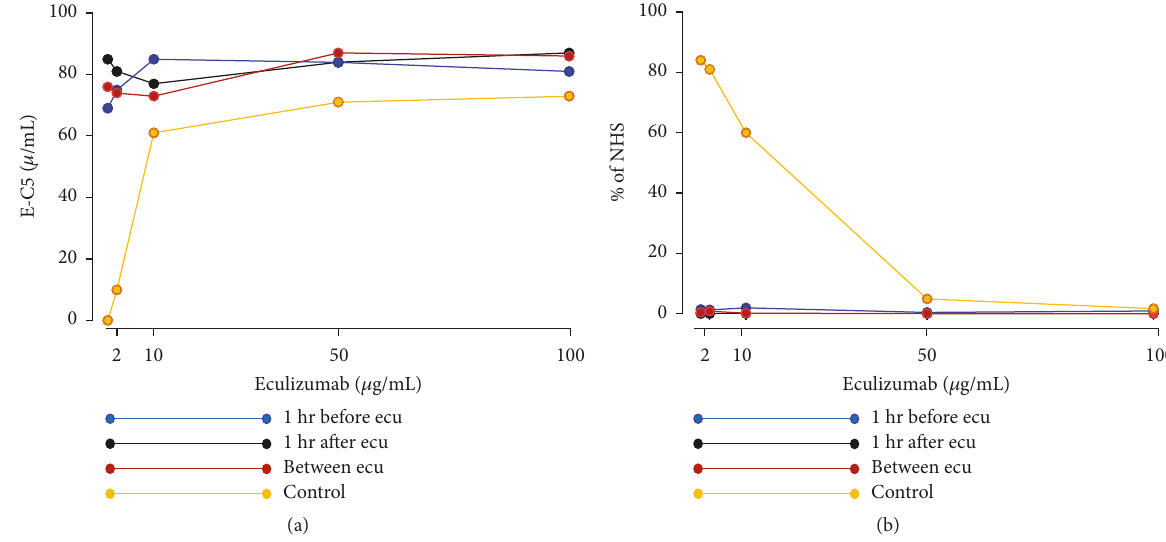
Figure 1: Patient samples and control sera assayed for eculizumab-C5 (E-C5) complexes and total complement activity. Three samples from the aHUS patient were examined: (1) sample obtained 1 hr before eculizumab infusion (“1 hr before ecu”), (2) sample obtained 1 hr after eculizumab infusion (“1 hr after ecu”), and (3) sample obtained 1 week after and 2 weeks before eculizumab infusion (“between ecu”). Control sera were obtained from 20 healthy controls. (a) Samples were incubated with increasing concentrations of eculizumab (0-100 𝜇 g/mL) and E-C5 complexes were measured (concentration is given in eculizumab-equivalent amounts). (b) Samples were incubated with increasing concentrations of eculizumab (0-100 𝜇 g/mL) and classical pathway complement activation was measured by the Wieslab (cid:2) assay, detected as % of a normal human standard sera by the kit, defined to contain 100% activity (% of